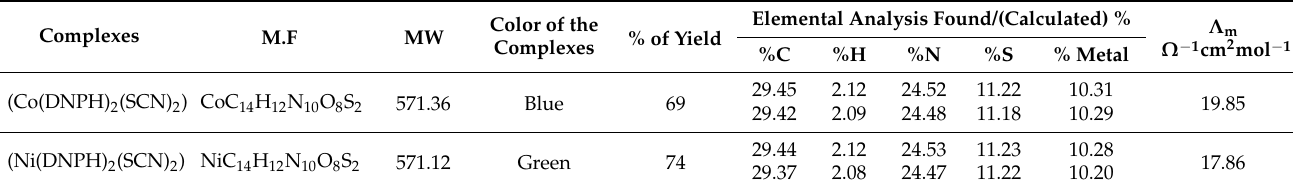
Table 1. Physical data, as well as analytical characterizations, of the metal compounds. Complexes M.F MW